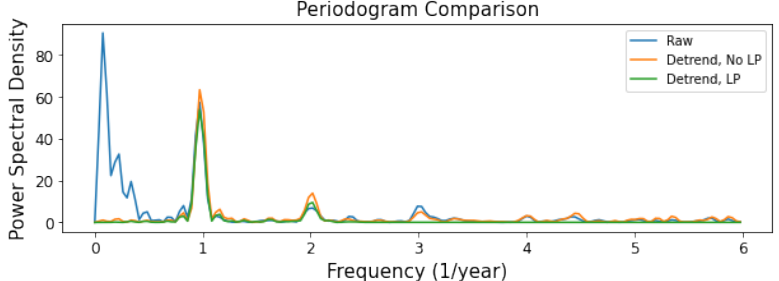
Figure 11. Periodogram with the comparison at different preparation